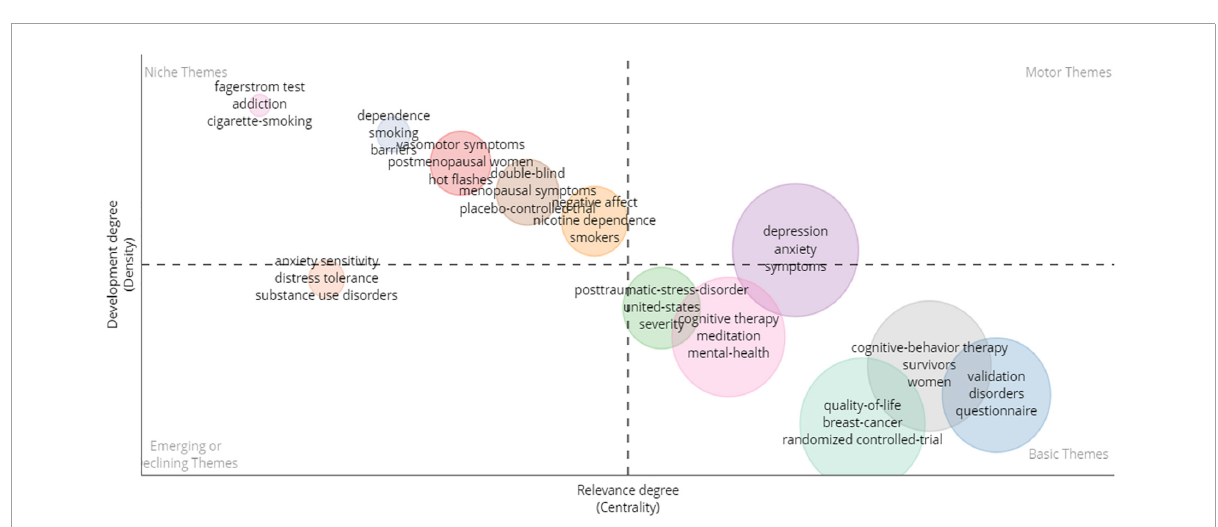
FIGURE12 Keywords plus of four quadrants. Motor themes (first quadrant); Niche themes (second quadrant); Emerging or declining themes (third quadrant); Basic themes (fourth quadrant).